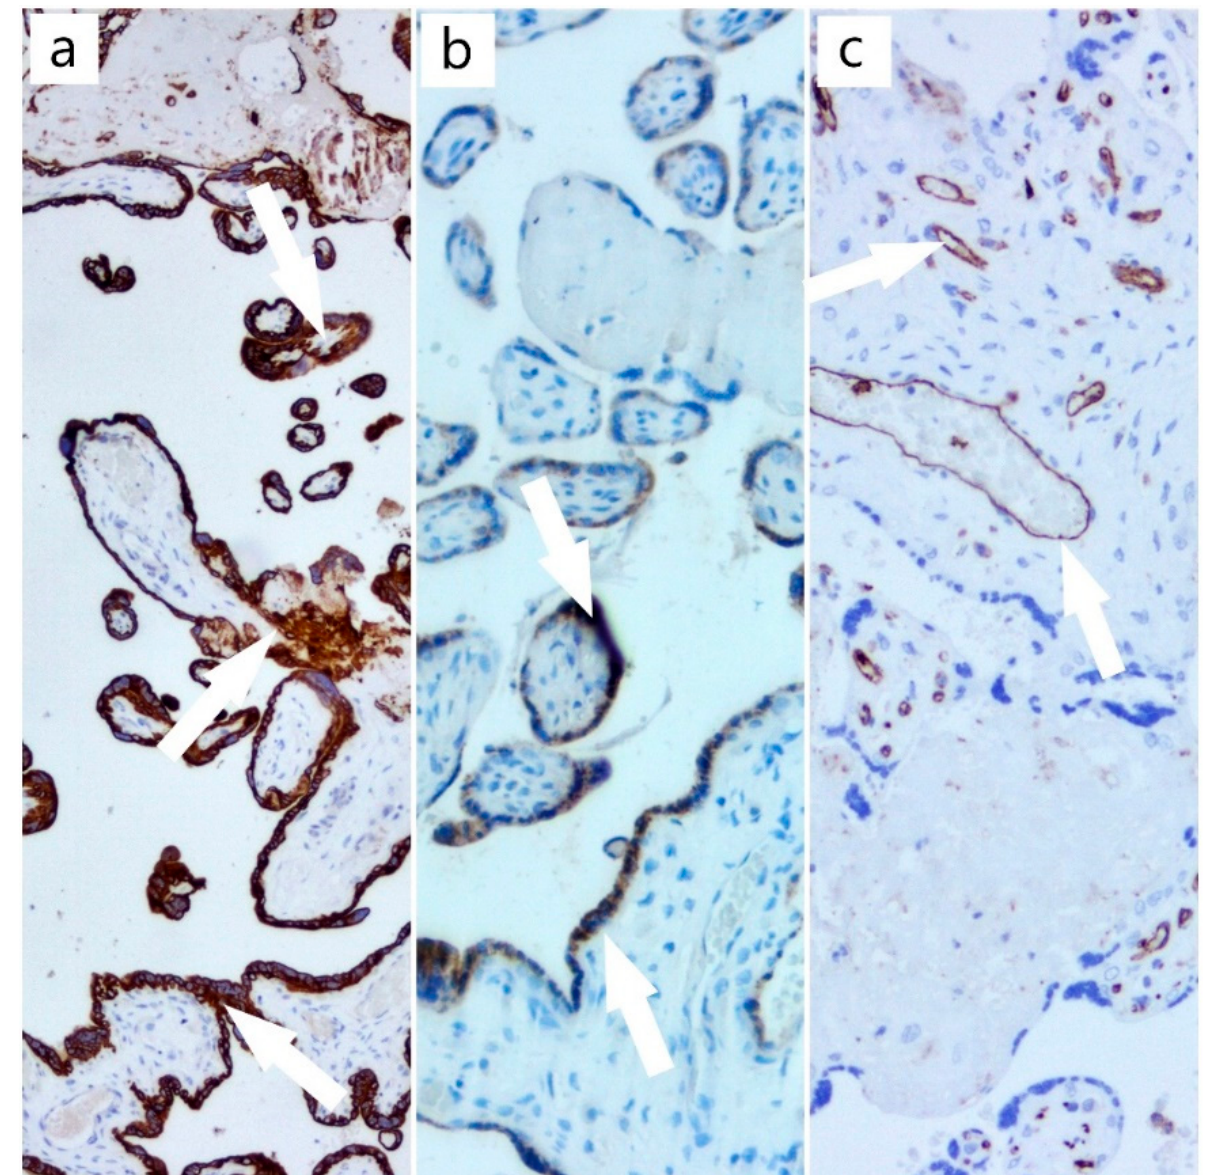
Figure 4. ( a ) CTK AE1/AE3 immunostain, ob. 5× (positive trophoblast with arrow); ( b ) β‐ hCG immunostain, ob. 10× (positive trophoblast with arrow) ; ( c ) CD31 immunostain, ob. 10× (positive for vascular endothelium from axis of chorionic villi with arrow).